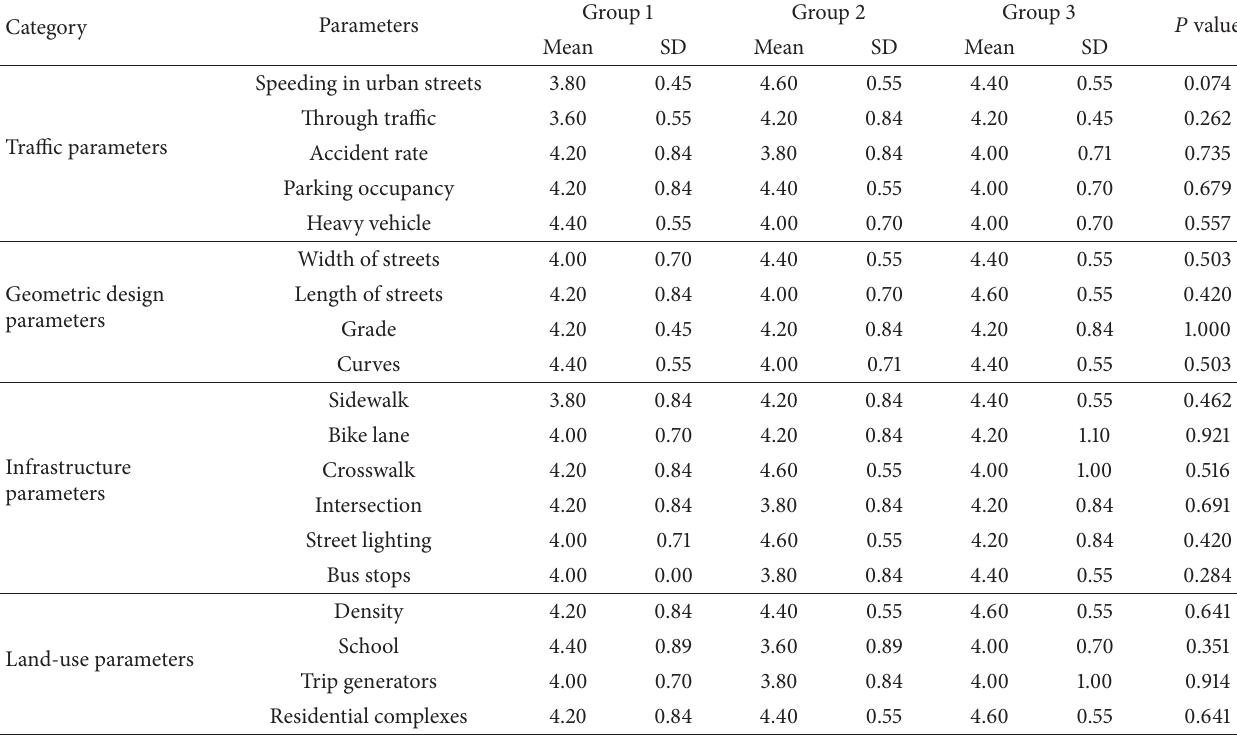
Table 3: Results from the questionnaire about the importance of the